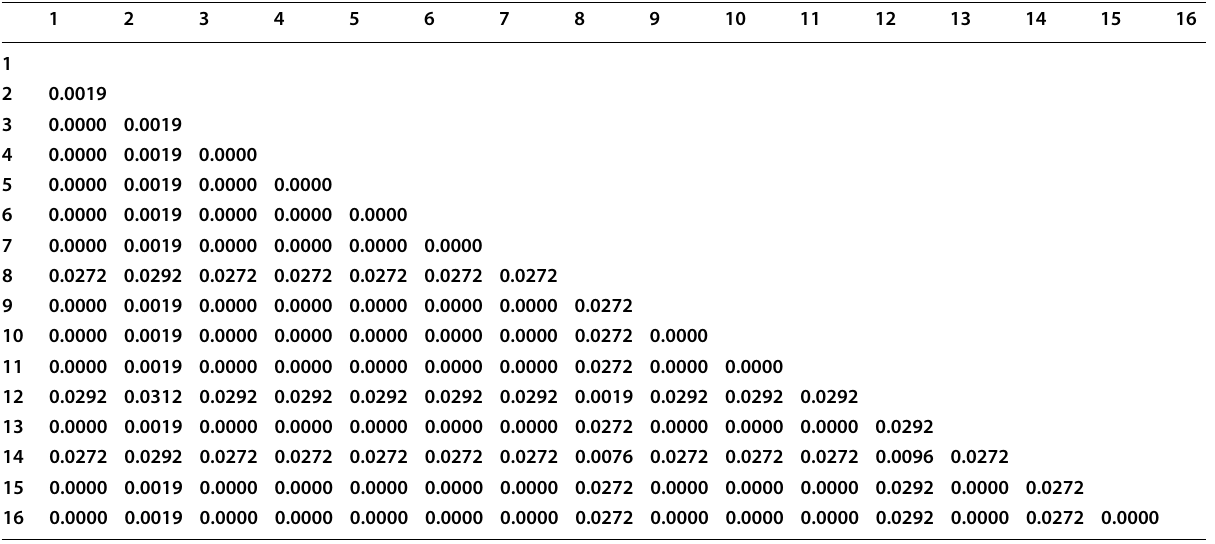
Table 1 Genetic distances between 16 camel populations based on mtDNA 16S rRNA gene